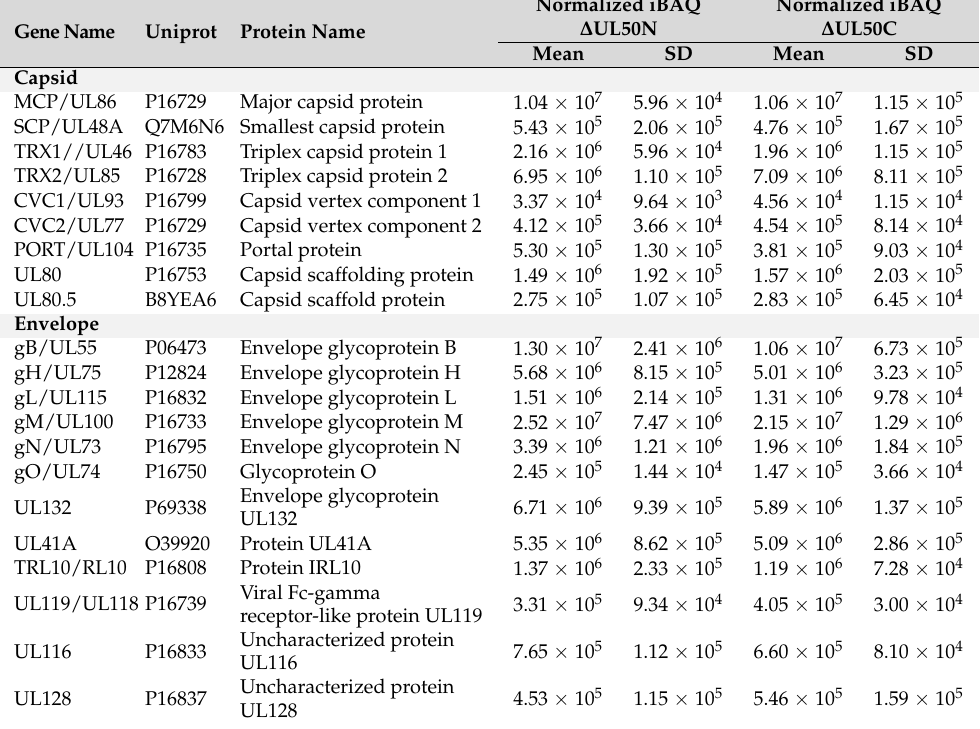
Table 1. Classes of HCMV structural proteins contained in ∆ UL50C and ∆ UL50N NIEP fractions characterized by MS-based quantitative proteomics